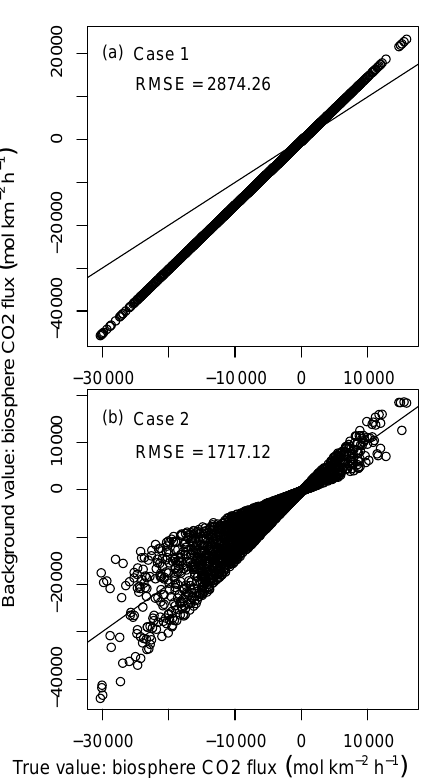
Figure 12. The first-guess biosphere CO 2 fluxes used in the two inverse modeling experiments. The x axis is the true daily mean CarbonTracker biosphere CO 2 value (as shown in Fig. 4), and the y axis is the first guess (background value). The solid line in each figure is the 1 : 1 line.